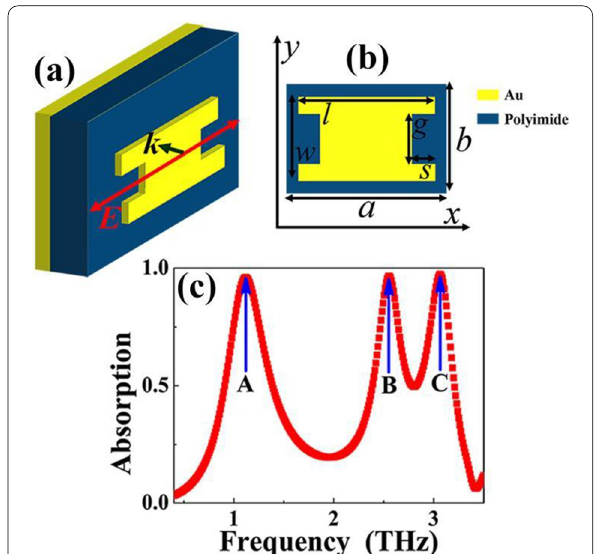
Fig. 1 a Three‑dimension structure sketch of the triple‑band MBLA, of which the red line with arrow indicates the polarization direction of incident electromagnetic wave, the black line with arrow gives the propagation direction of incident electromagnetic wave; b Front view of the triple‑band MBLA; c Simulated absorption spectra of the designed device as a function of